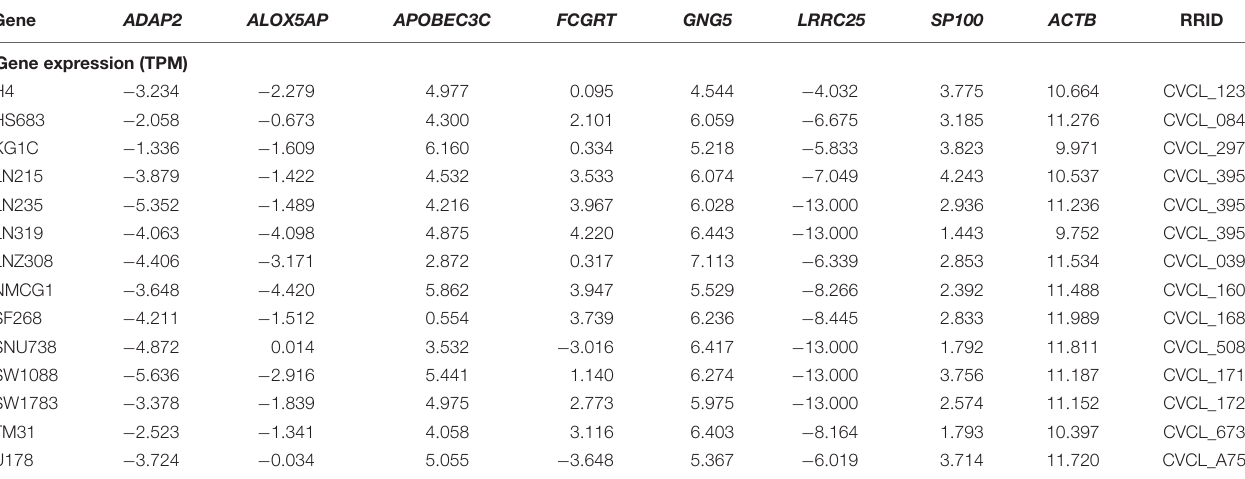
TABLE 4 | List the expression of the seven genes in 14 LGG cell